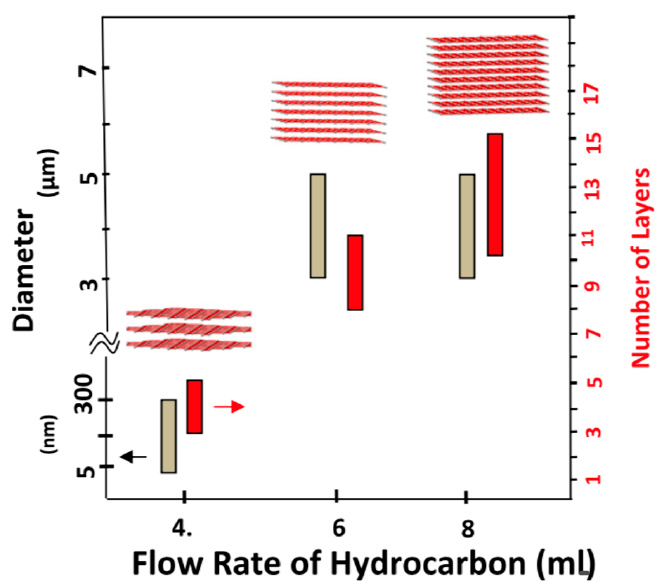
Figure 6. Flow rate of acetylene as the hydrocarbon feedstock versus the diameter and the number of layers produced in CVD has grown graphene (reprinted with permission from [66]).